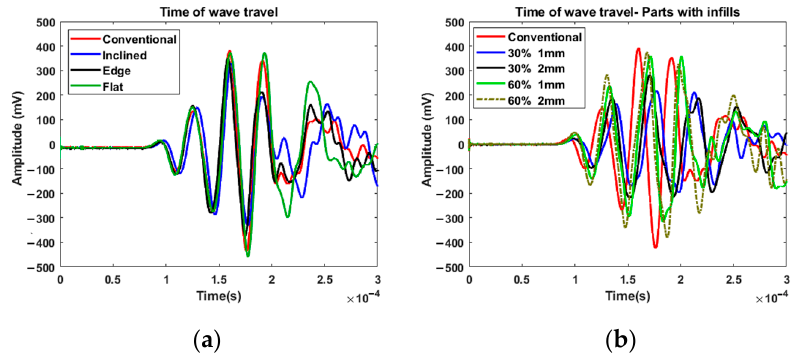
Figure 4. Surface wave travel time in: ( a ) solid parts; ( b ) parts with infills.